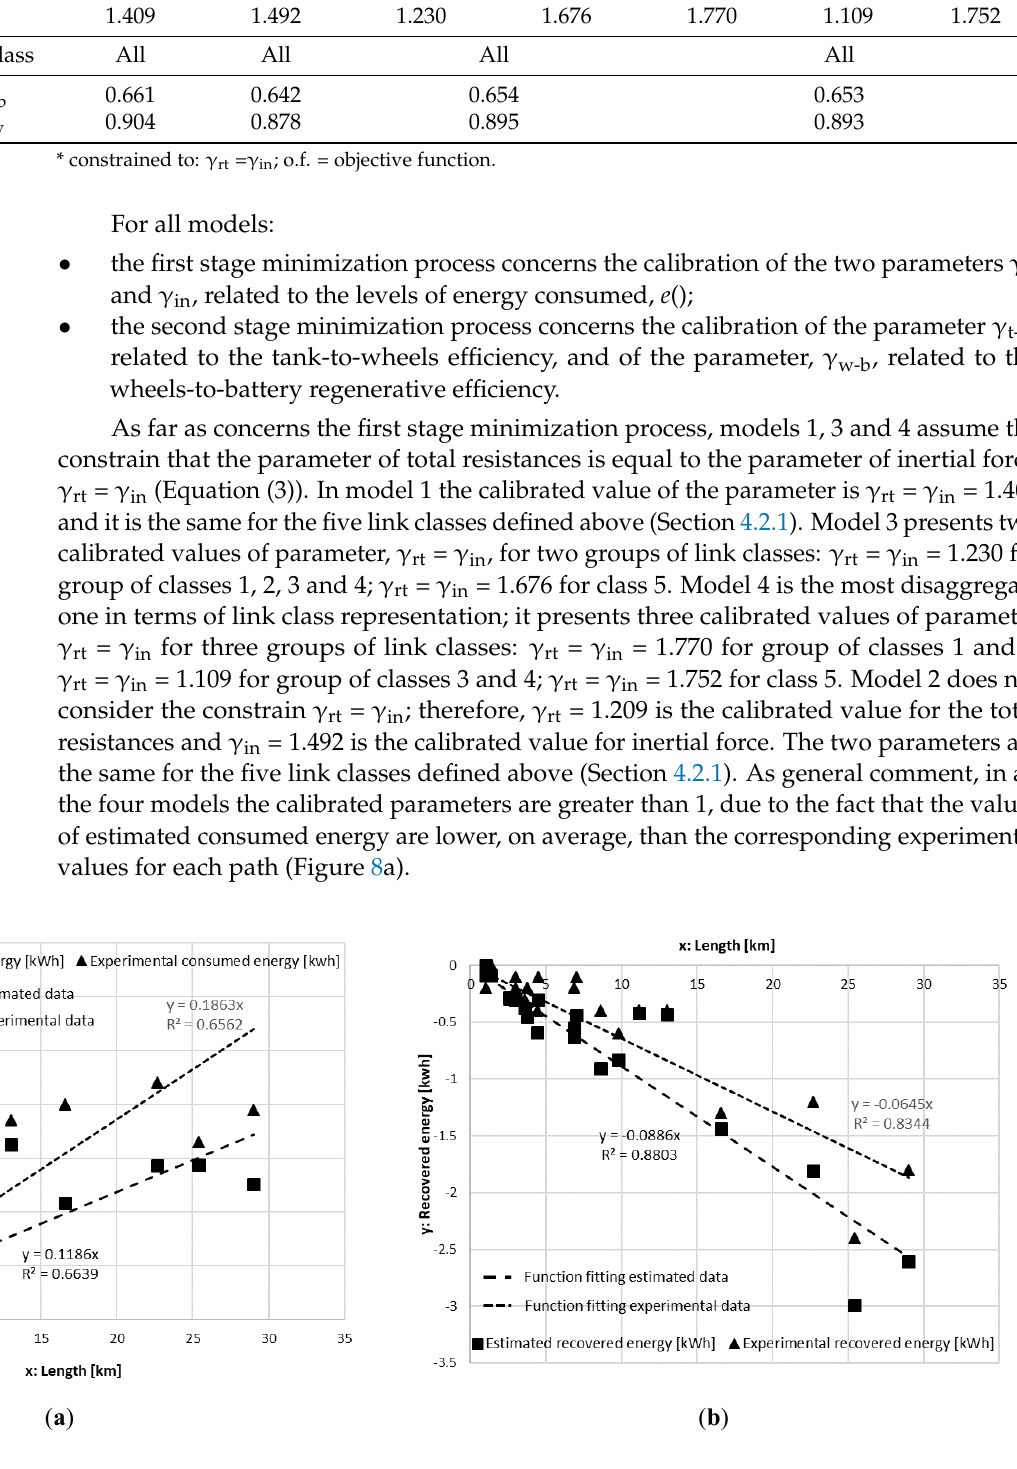
Figure 8. Estimated energy consumption with parameters of literature and experimental energy consumption with probe EVs vs. path length: consumed energy ( a ) and recovered energy ( b ).